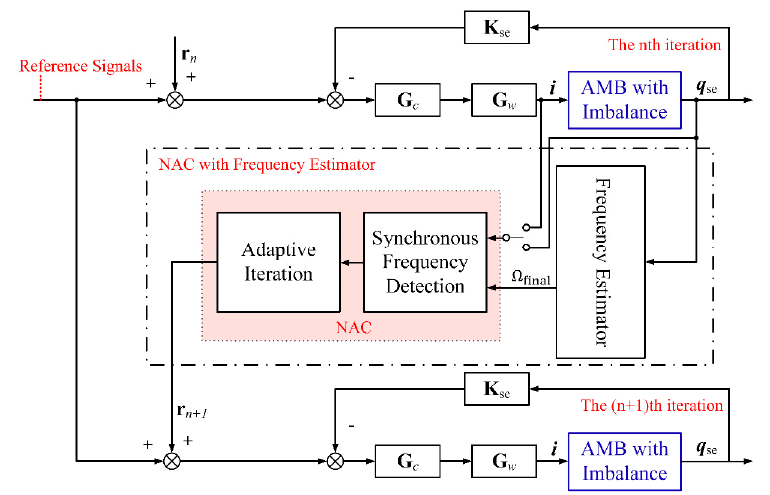
Figure 3. Block diagram of the overall algorithm structure.